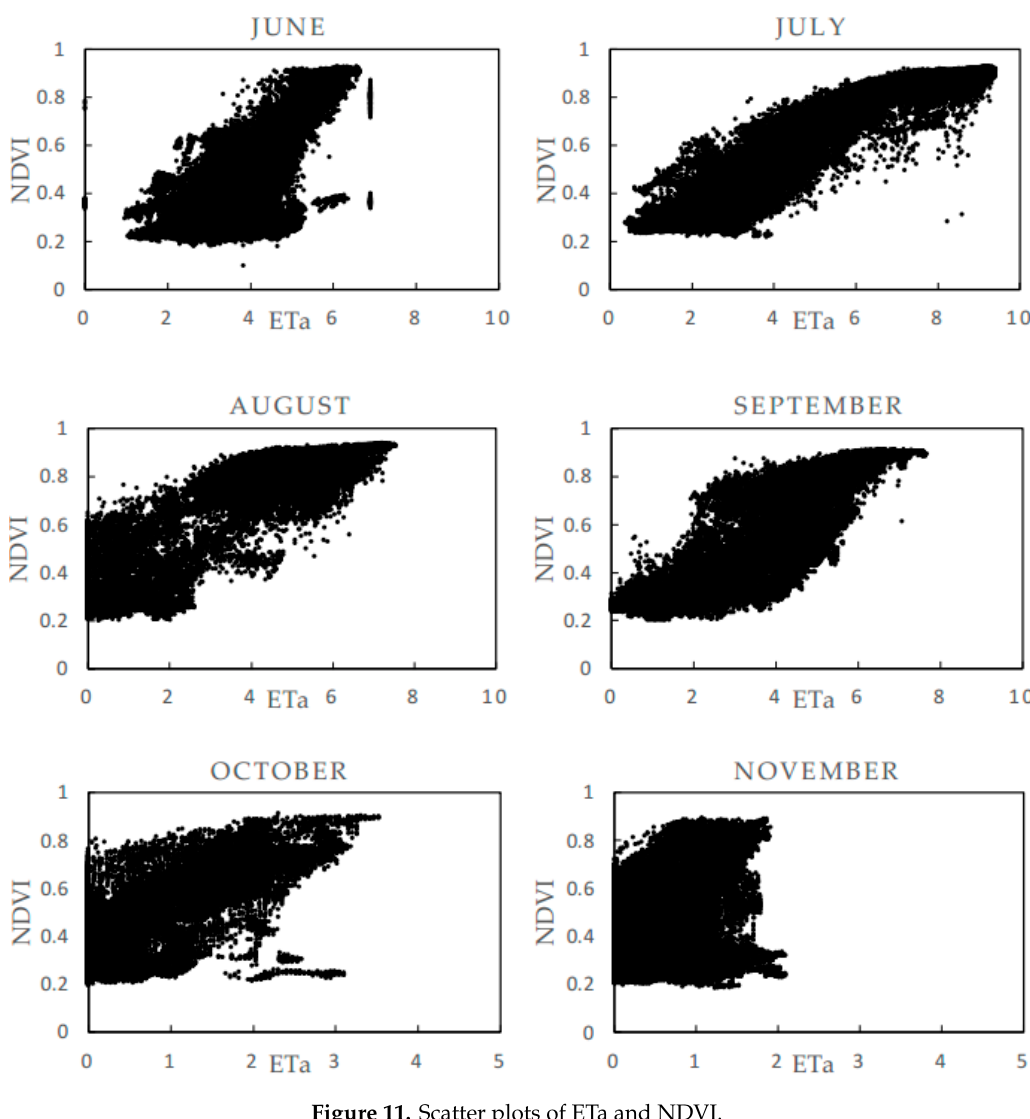
Figure 11. Scatter plots of ETa and NDVI. Table 7. Confusion matrix of study area 3 based on NDVI time series 3.